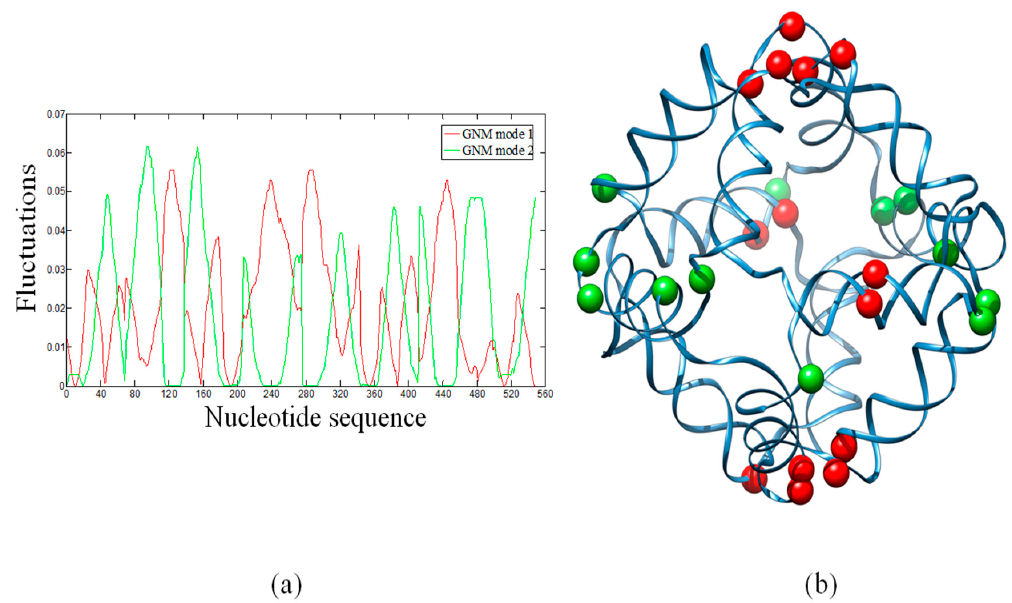
Figure 2. ( a ) Sequence-based fluctuations of the first and the second GNM modes of the DNA octahedron. Minima of the two modes correspond to hinge sites; ( b ) The distribution of hinge sites mapped to the three-dimensional structure. Red beads and green beads are hinges predicted by the first and the second GNM mode, respectively. The beads are mainly located over, or in the proximity, of the polyhedral vertices (i.e., the single strand thymidine bridges).